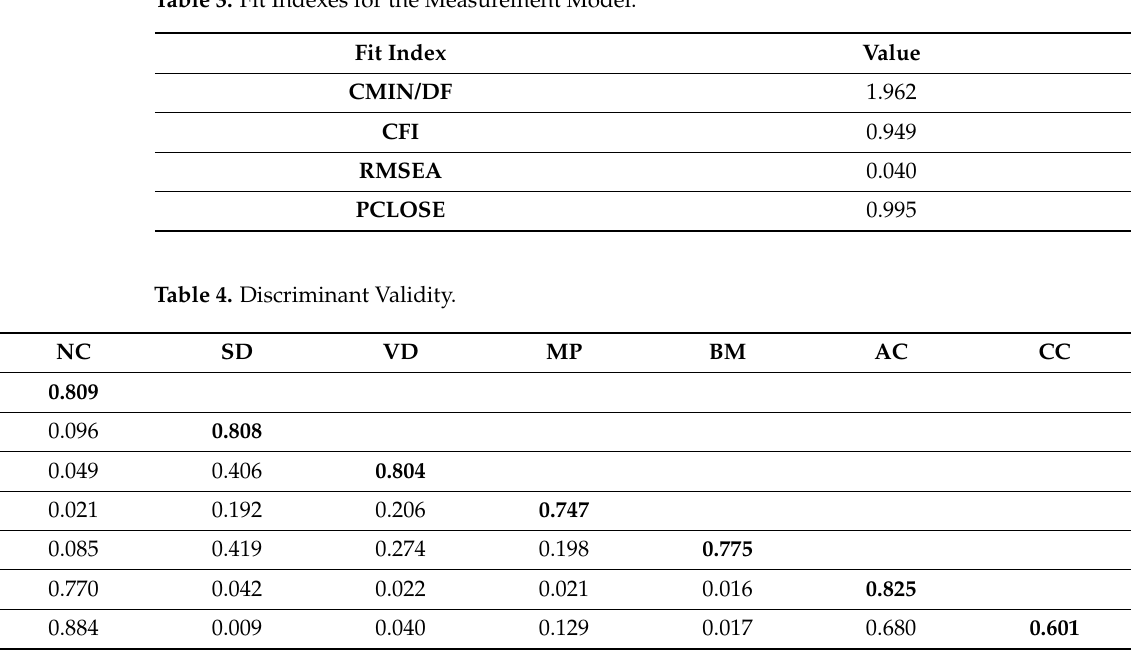
Table 3. Fit Indexes for the Measurement Model.